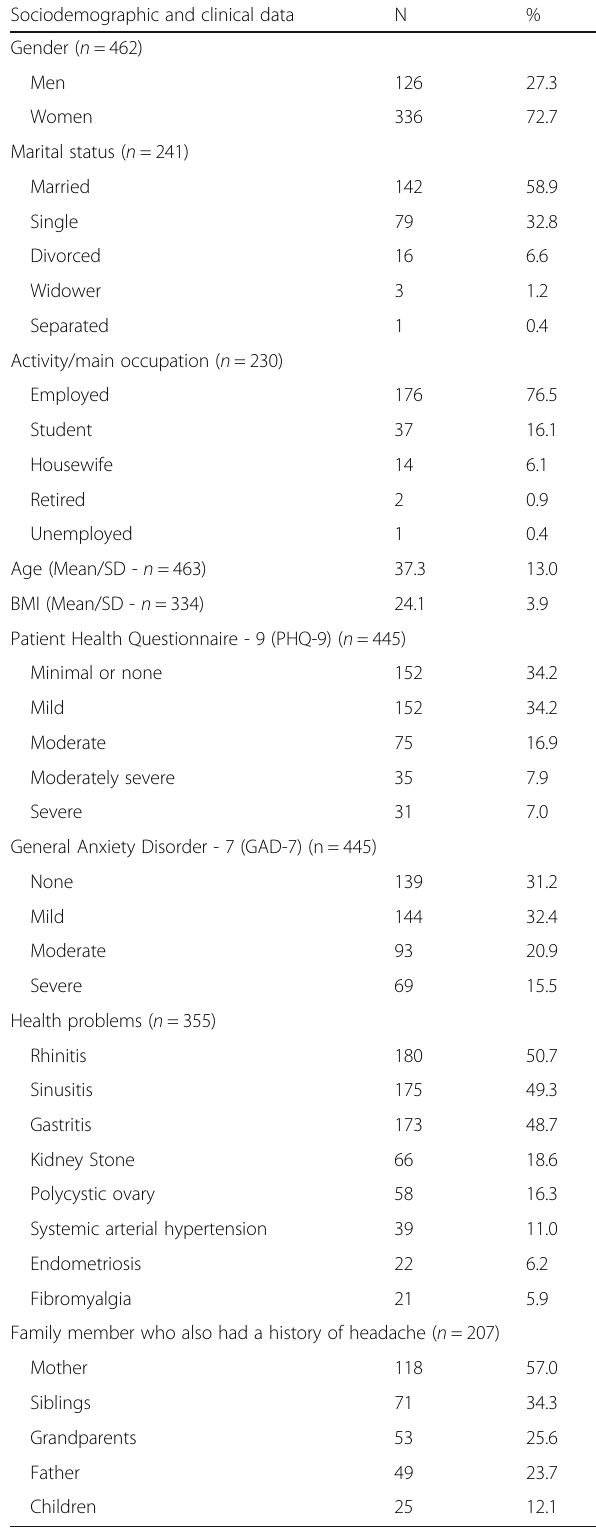
Table 1 Sociodemographic and clinical characteristics of